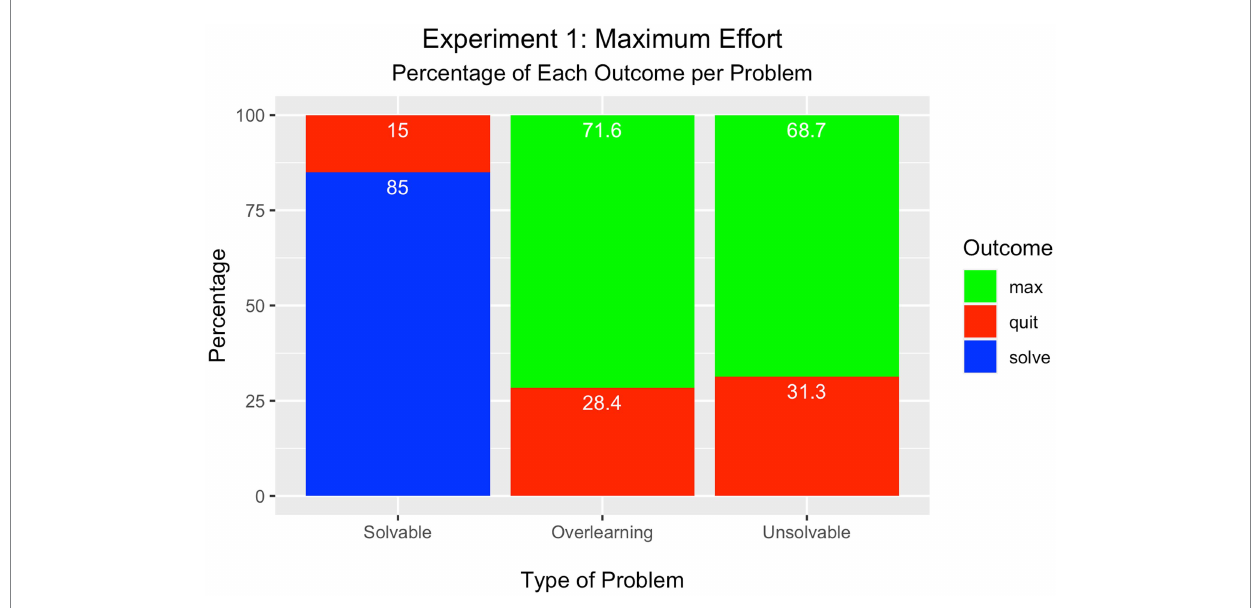
FIGURE 2 Experiment 1 – Maximum Effort